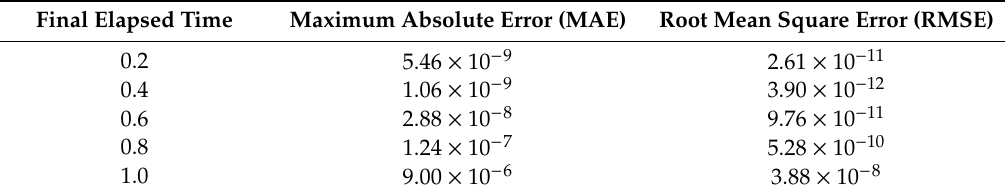
Table 3. MAE and RMSE of the proposed approach for solving the